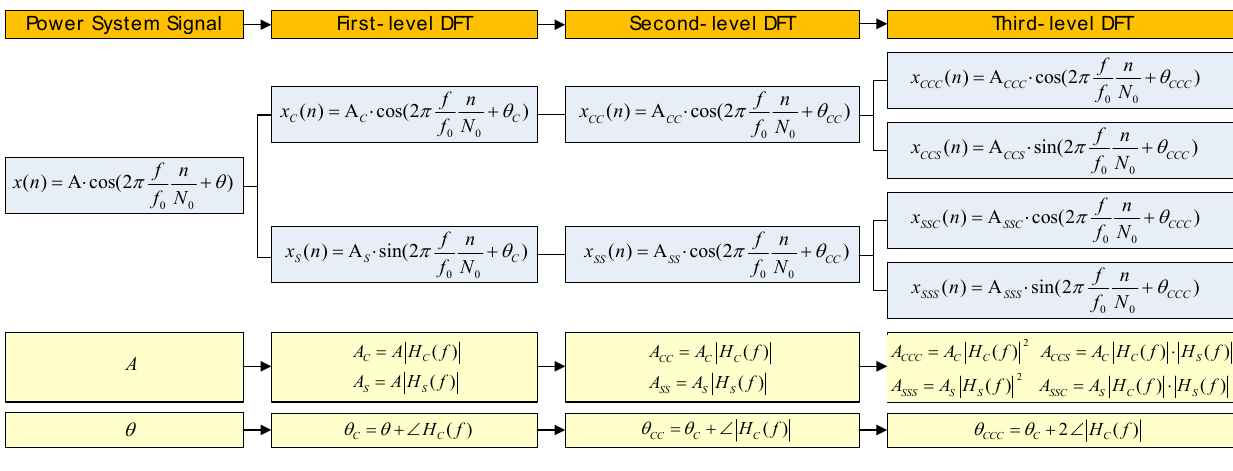
Figure 1. Amplitude and phase relations of the output signals in the three-level DFT